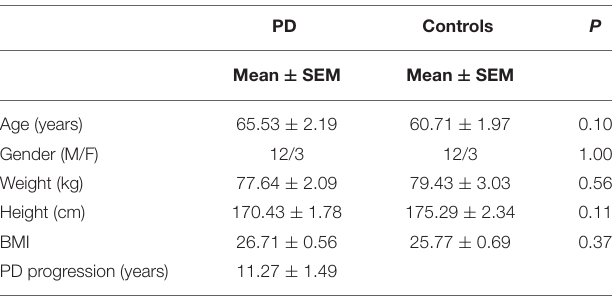
TABLE 2 | Characteristics of the patients who participated in the sleep rhythm evaluation study in Parkinson’s